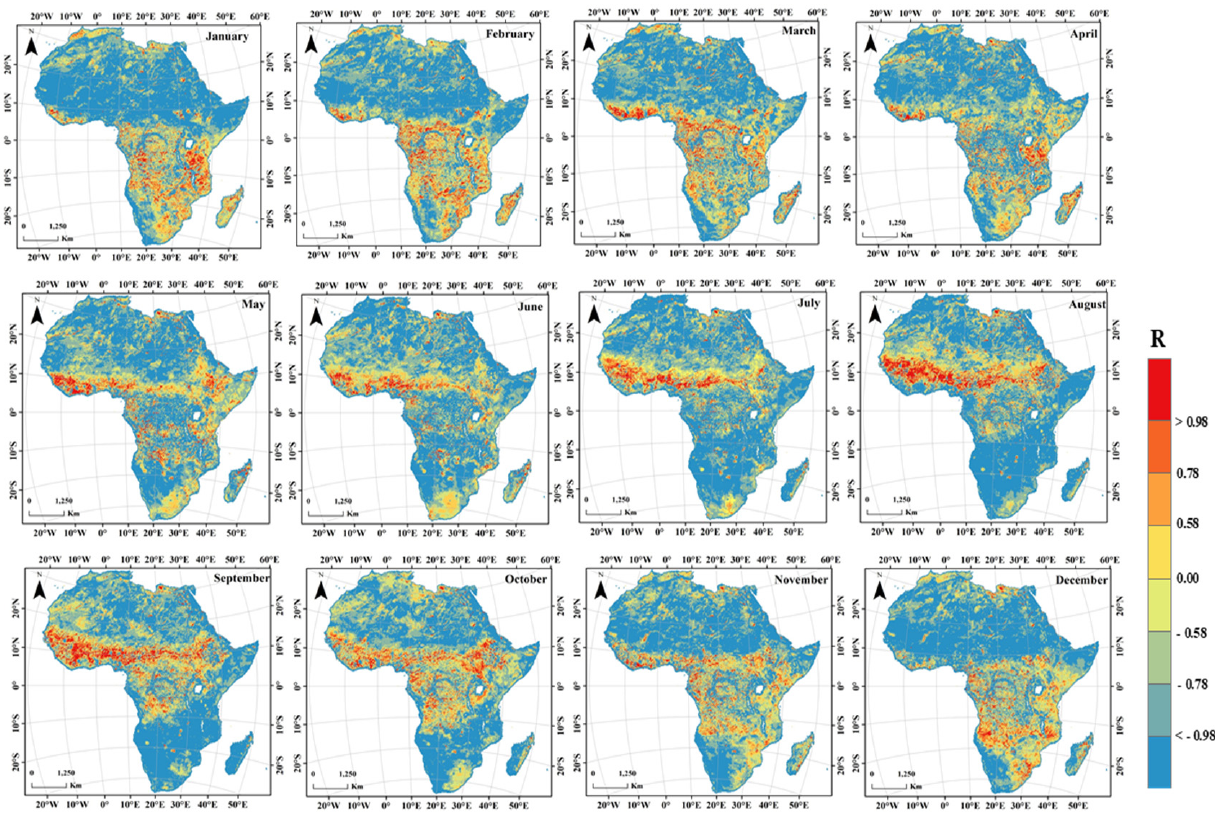
Figure 10. The interannual change correlation coefficient (R) of the monthly average soil moisture content from 2003 to 2017.